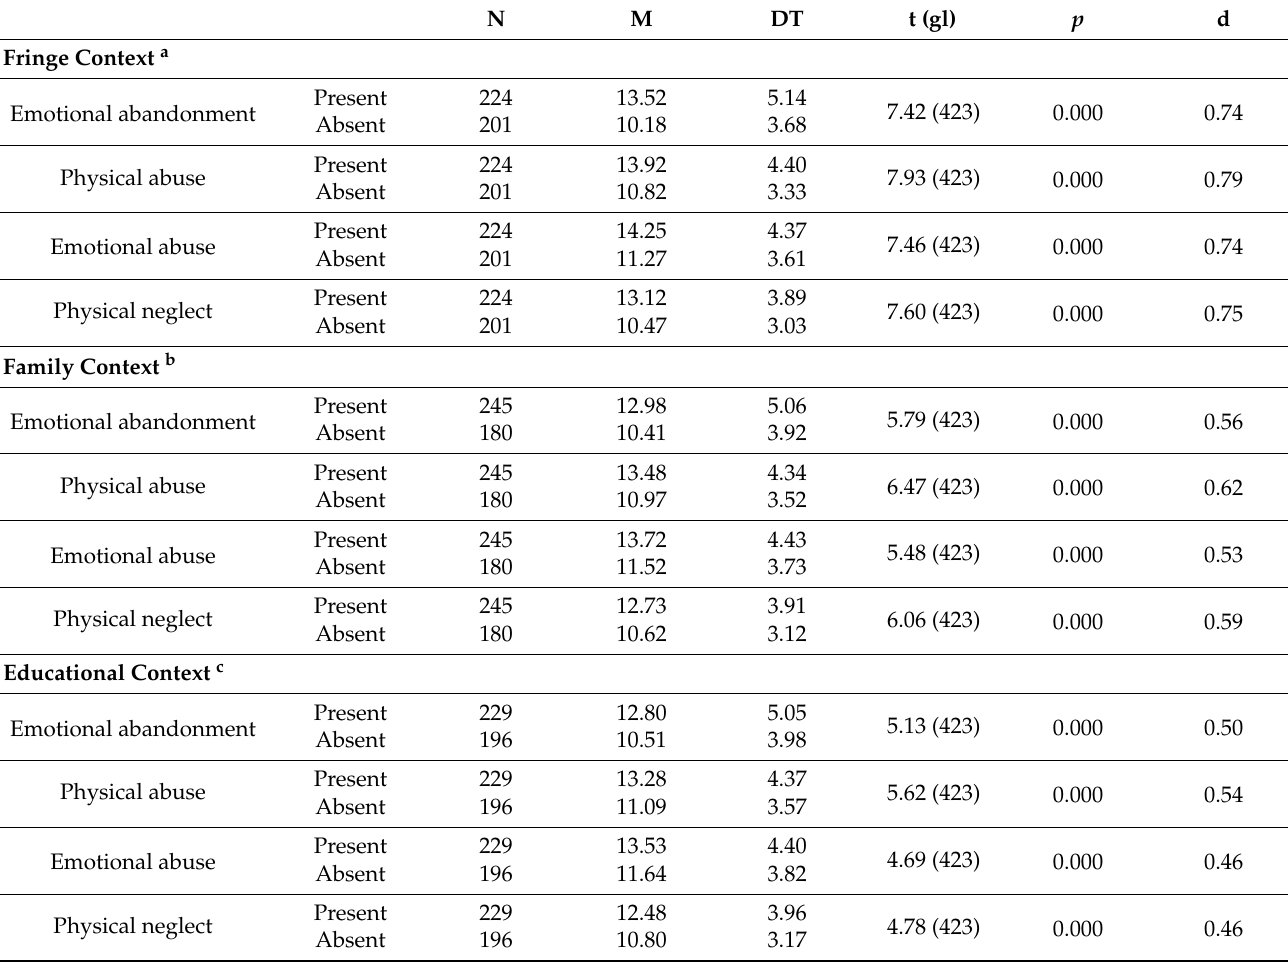
Table 7. Comparison of means for the type of abuse according to the